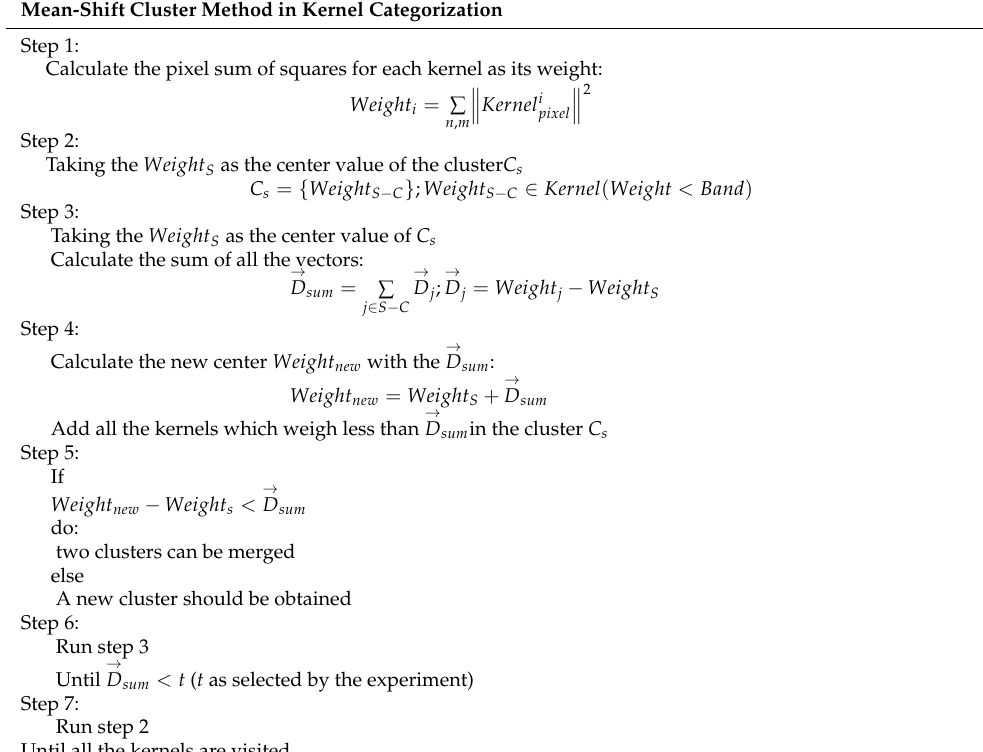
Table 3. The flow of the mean-shift cluster method in kernel categorization. Mean-Shift Cluster Method in Kernel